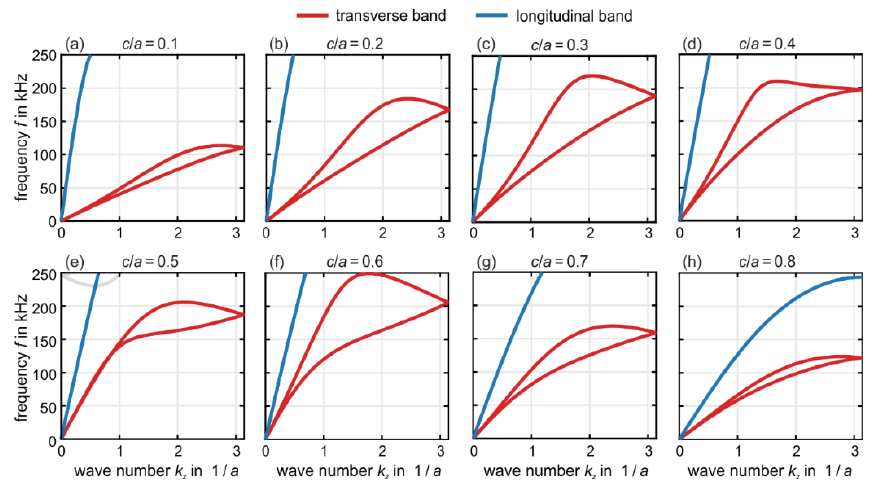
Figure 3. Calculated bulk phonon band structures (i.e., 𝑁 𝑥 = 𝑁 𝑦 = 𝑁 𝑧 → ∞) for the metamaterial defined in Figure 1. The lattice constant 𝑎 and the other parameters are the same as in Figure 2c, where 𝑐/𝑎 = 0.2 , but we vary the 𝑐/𝑎 ratio (as indicated). The bands are colored as in Figure 2. In particular, the chiral transverse acoustical bands are again highlighted in red. ( a ) 𝑐/𝑎 = 0.1 , ( b ) 𝑐/𝑎 = 0.2 , ( c ) 𝑐/𝑎 = 0.3 , ( d ) 𝑐/𝑎 = 0.4 , ( e ) 𝑐/𝑎 = 0.5 , ( f ) 𝑐/𝑎 = 0.6 , ( g ) 𝑐/𝑎 = 0.7 , and ( h ) 𝑐/𝑎 = 0.8 . For each 𝑐/𝑎 ratio, an inset illustrates the corresponding metamaterial unit cell.